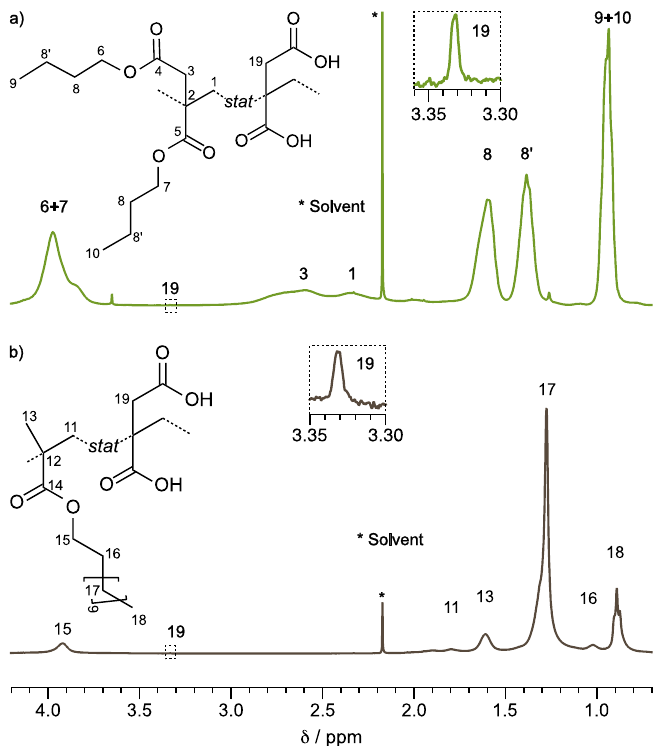
Figure 1. 1 H-NMR spectra of films copolymers in CDCl 3 . ( a ) PSA-1000 (Poly(DBI 99 - stat- IA 1 )); ( b ) PSA-5000 (Poly(LMA 99 - stat- IA 1 )).